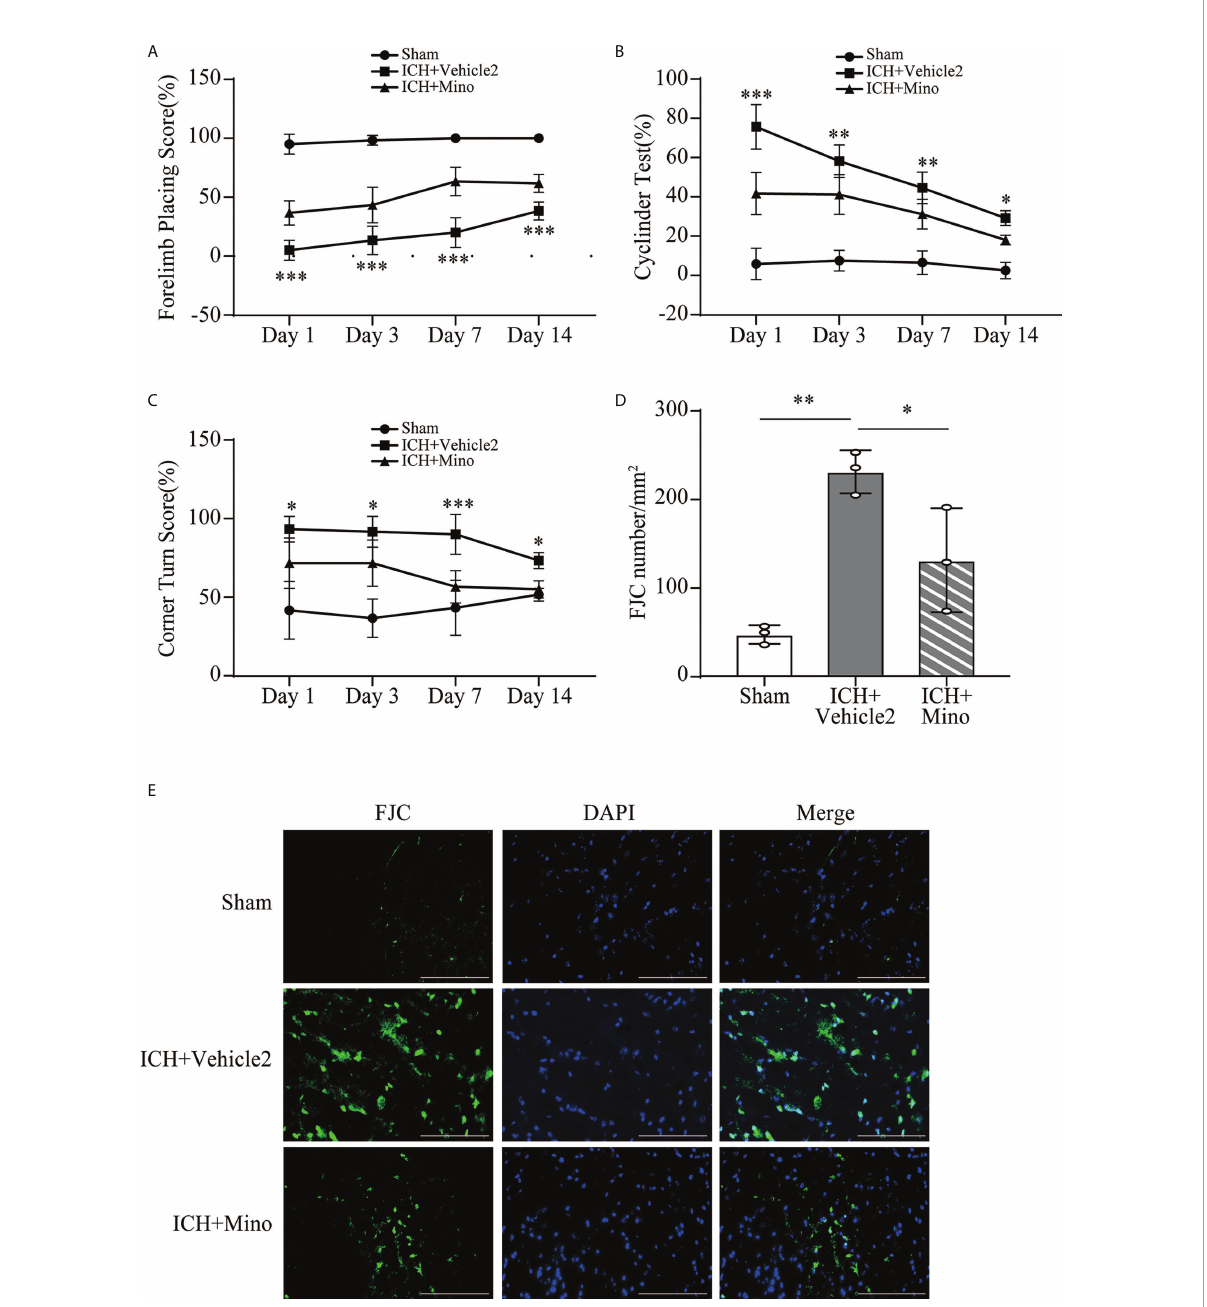
FIGURE 6 The neuroprotection of minocycline on brain injury after ICH. (A – C) Quanti fi cation of neurological function in the forelimb placing test (A) , cylinder test (B) , and corner turn test (C) at days 1, 3, 7, and 14. n = 6, *P <0.05, **P <0.01, ***P <0.001 versus the ICH + Mino group by two- way ANOVA. (D, E) Representative immuno fl uorescence images and quantitative analysis of FJC-positive cells in the ipsilateral cerebral cortex. n = 3. *P <0.05, **P <0.01 by one-way ANOVA. Scale bar = 100 m m. Data are represented as mean ±